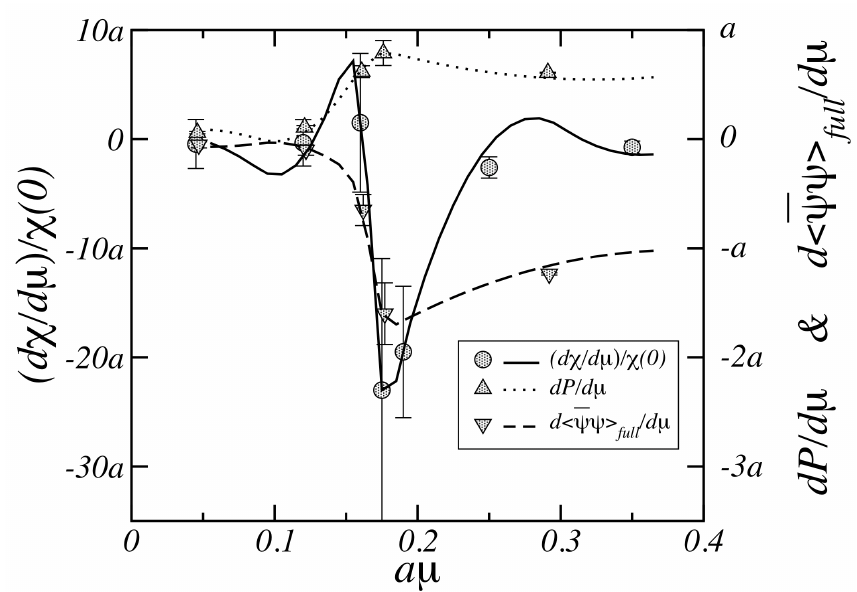
Figure 4. The correlation among topology, confinement and chiral symmetry as seen from the µ B derivatives of the topological susceptibility, the Polyakov loop and the chiral condensate in two-color QCD, on a hot lattice. From Ref. [58].